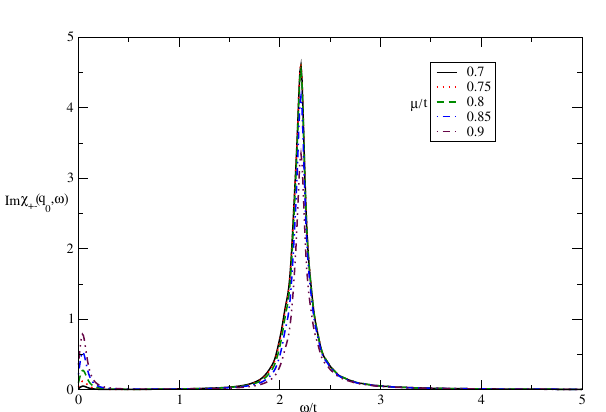
Figure 10. The imaginary part of dynamical transverse spin susceptibility Im χ Germanene layer versus normalized frequency ω/ t for different values of normalized magnetic field g µ B B / t at 0.6 . The normalized temperature is considered to be k fixed spin-orbit coupling (cid:31) / t =